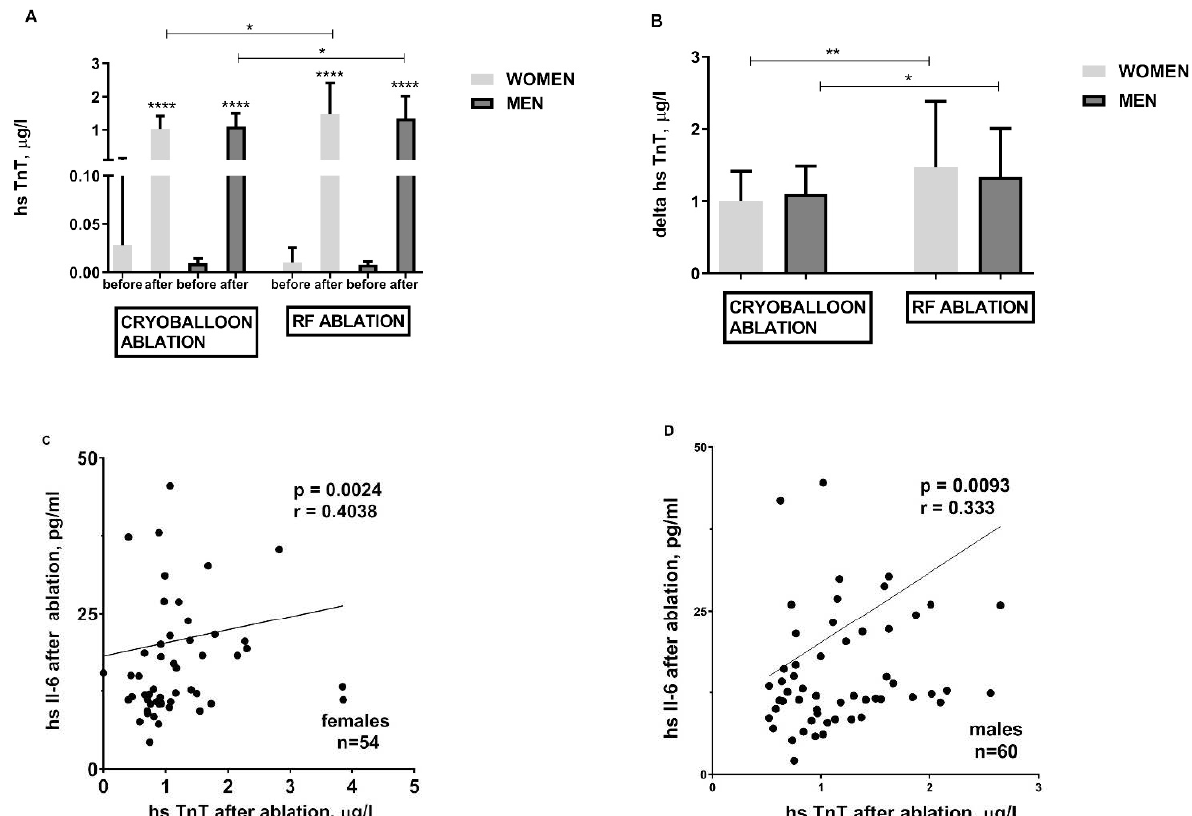
Figure 3. Troponin concentration before and after cryoballoon and RF ablation and its relationship with ablation-induced inflammatory process in obese females and obese males; panel ( A )—hs TnT elevation in response to CB and RF ablation; panel ( B )—hs TnT difference before and after cryoballoon and RF ablation (delta); The relationship between the degree of troponin release and the intensity of inflammation in the group of females panel ( C ) and males panel ( D ). Asterisks represent a significant difference: * p < 0.05, ** p < 0.01, *** p < 0.001, **** p < 0.0001.